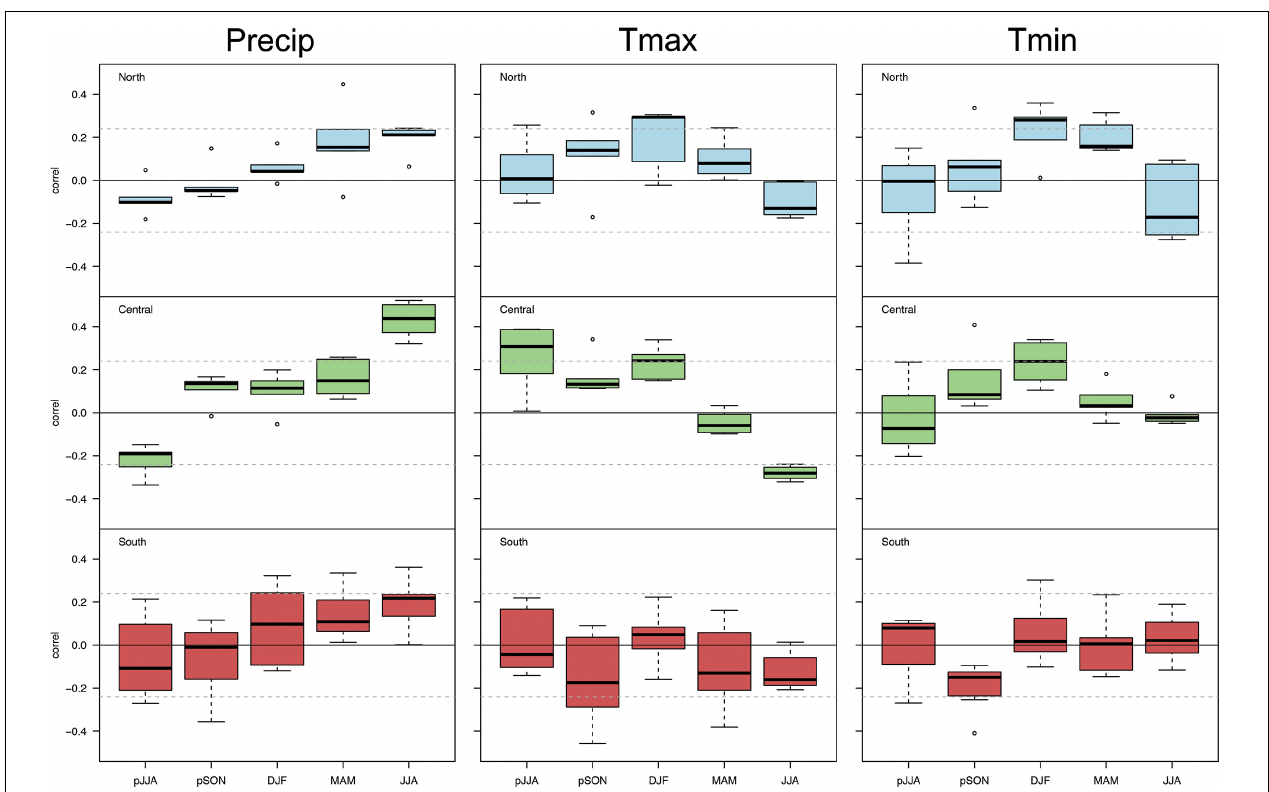
FIGURE 4 | Box plots of correlation statistics of population-level Chamaecyparis thyoides growth versus total seasonal precipitation, average maximum seasonal temperature, and average minimum seasonal temperature by region, North (top panel, light blue), Central (middle panel, green), and South (bottom panel, red). The range of correlations represent average population-level growth in each region. Dashed, horizontal lines represent a significance level of p ≤